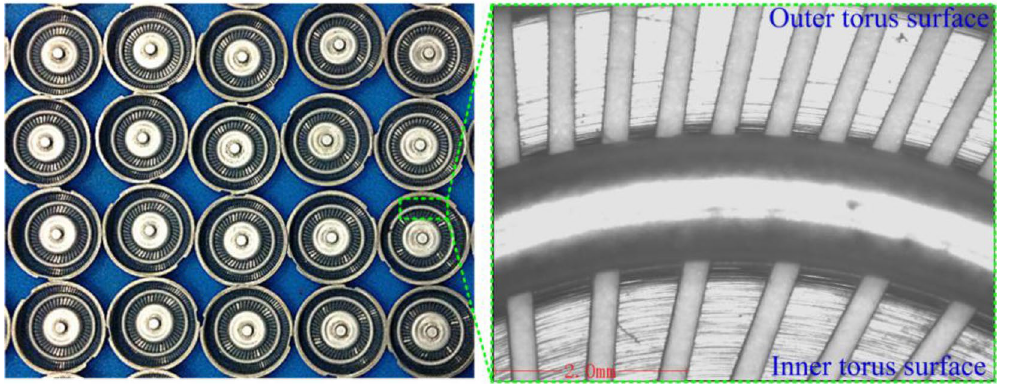
Figure 11. Torus surfaces processed with optimized